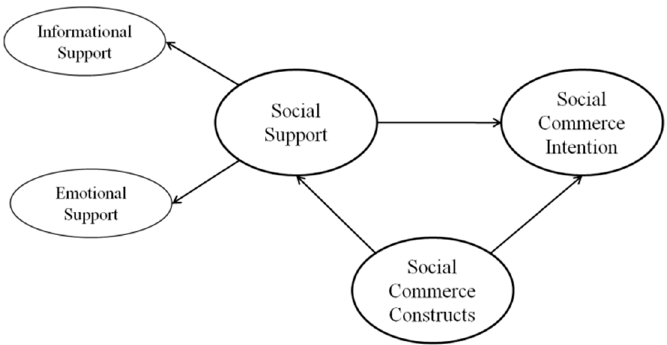
Figure 1. Social commerce intention model.